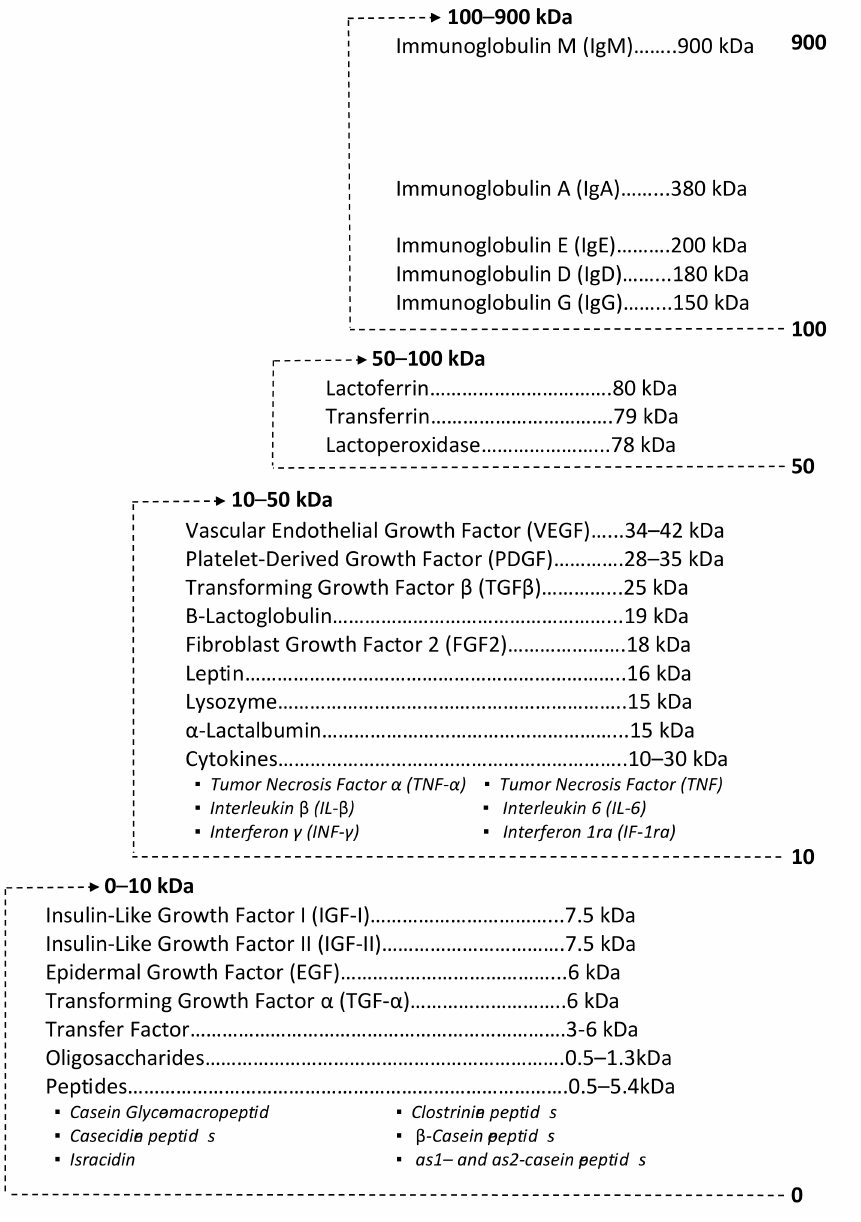
Figure 1. Molecular weight distribution for select components of Bovine colostrum